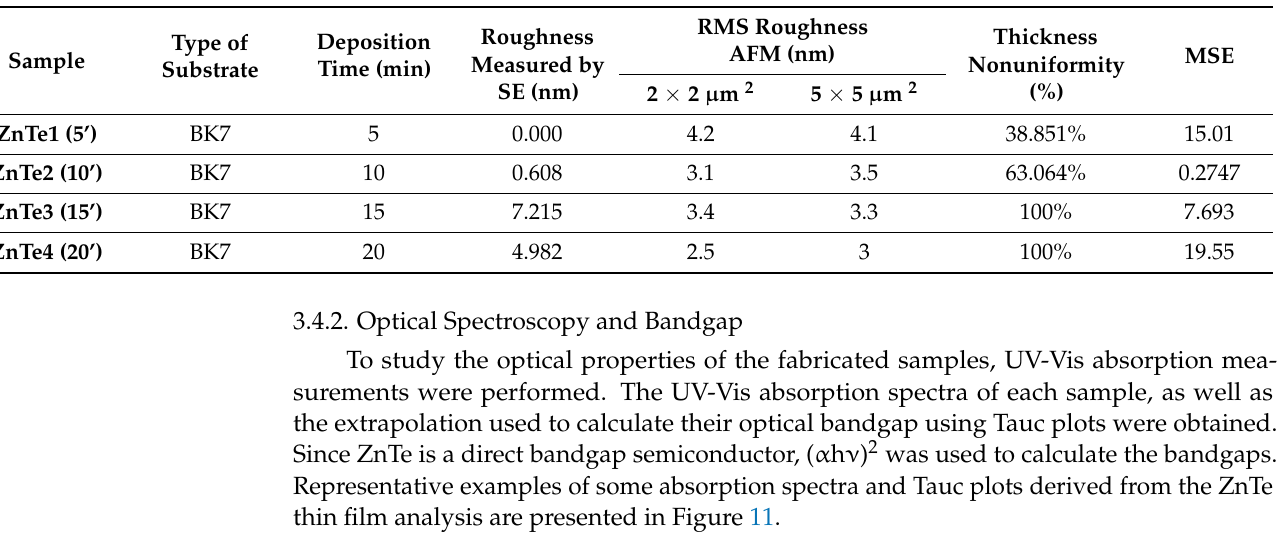
Table 3. Surface roughness measured by SE and AFM on ZnTe samples that have different deposition times.